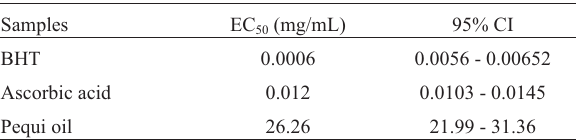
Table 2 - Antioxidant activity of the pequi pulp oil by the DPPH assay. As controls, the antioxidants butylated hydroxytoluene (BHT) and ascorbic acid were